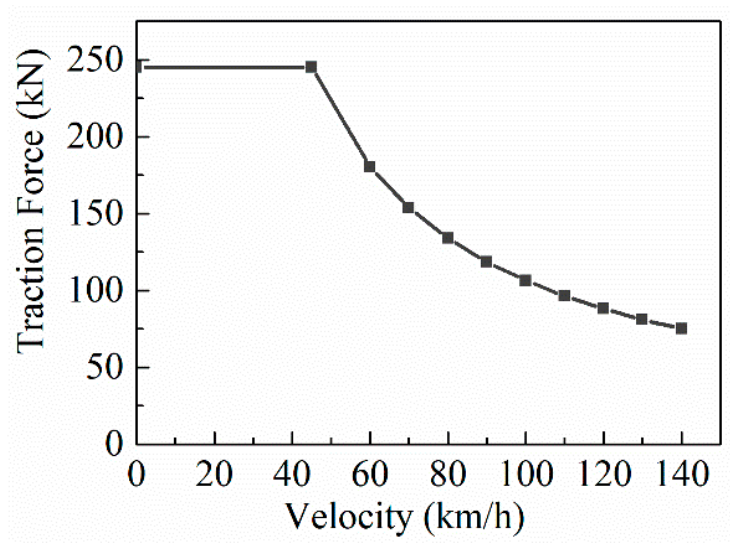
Figure 3. The relationship between the traction force and the vehicle